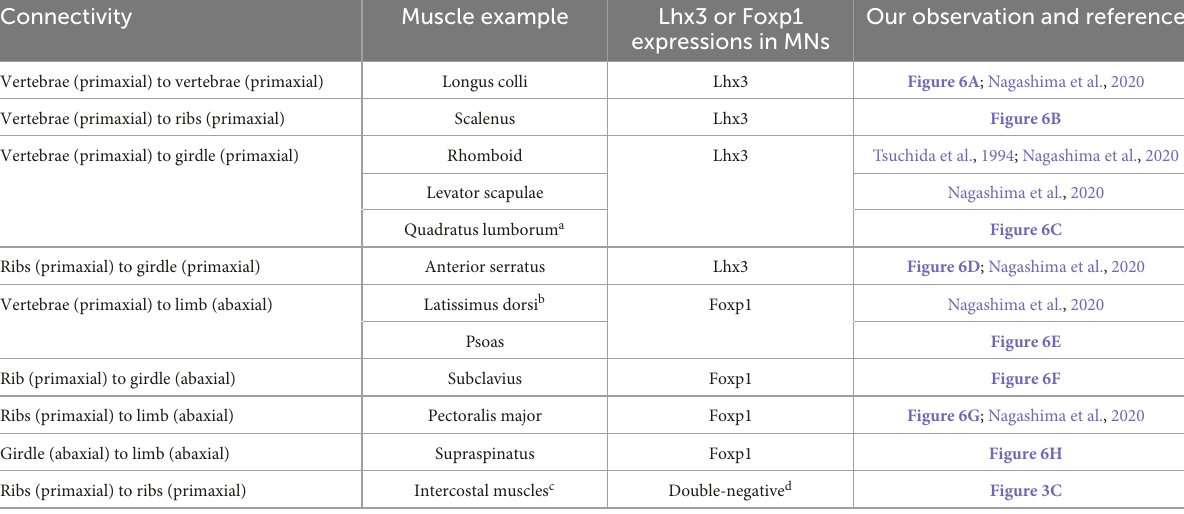
TABLE 1 Marker expression patterns in MNs innervating muscles spanning between various bones in the trunk and